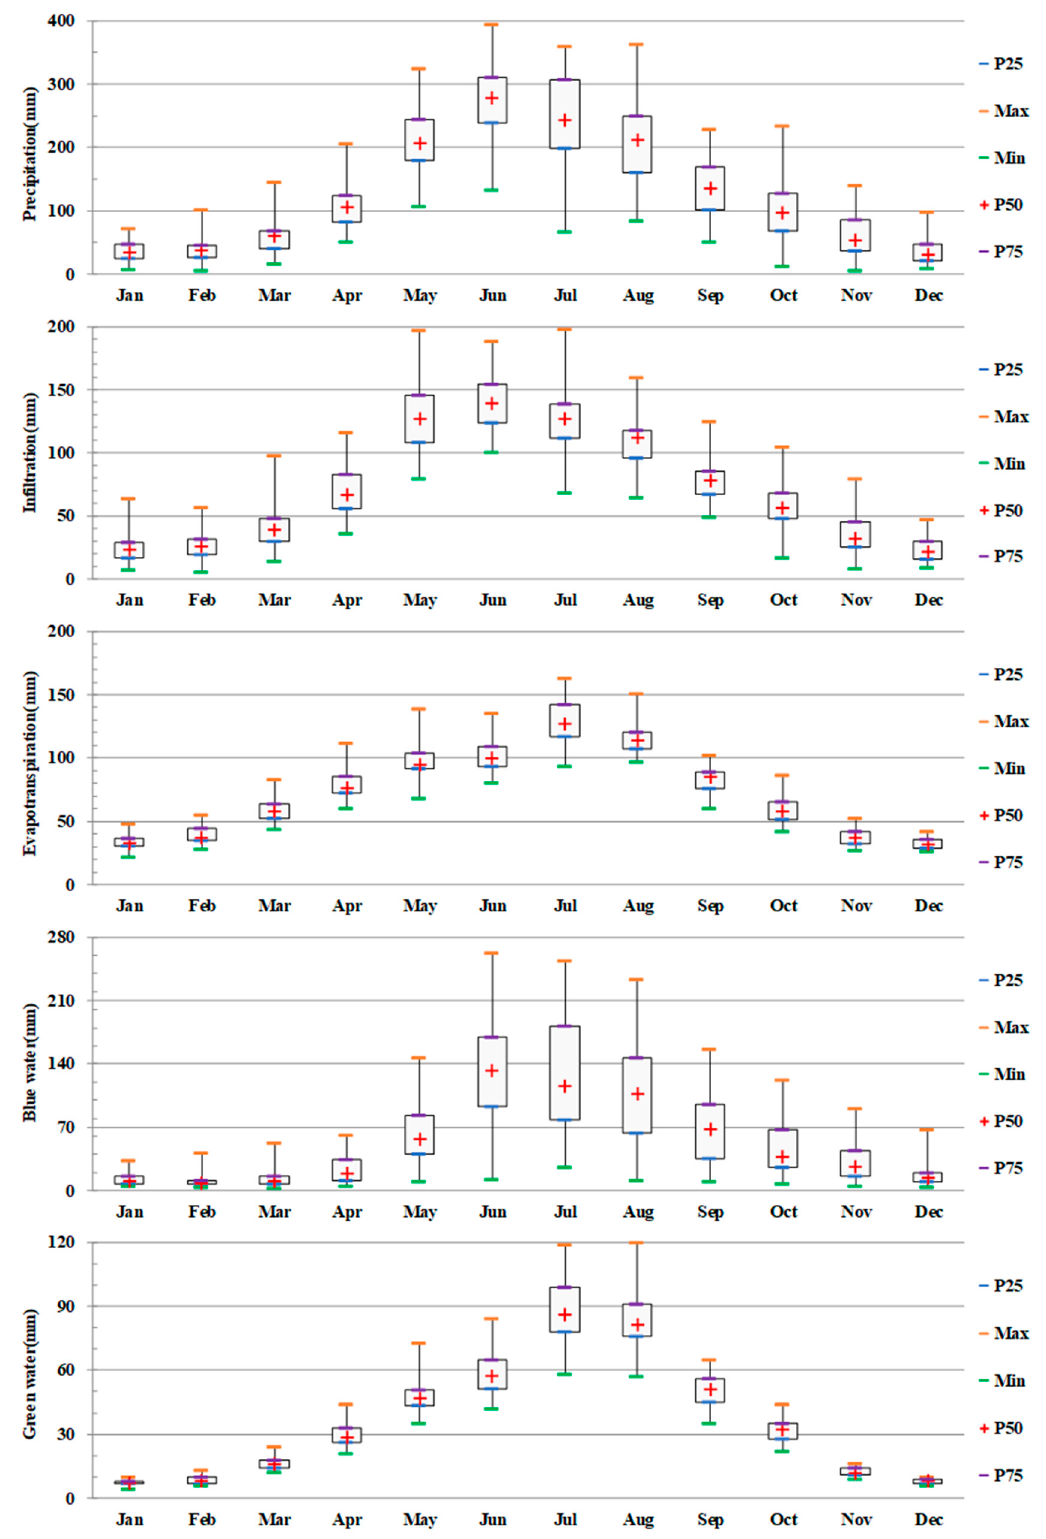
Figure 13. Intra-annual variability of water cycle fluxes in KMRSC. Min, P25, P50, P75, and Max denote the minimum, lower quartile, median, upper quartile, and maximum of monthly data from 1956 to 2015.